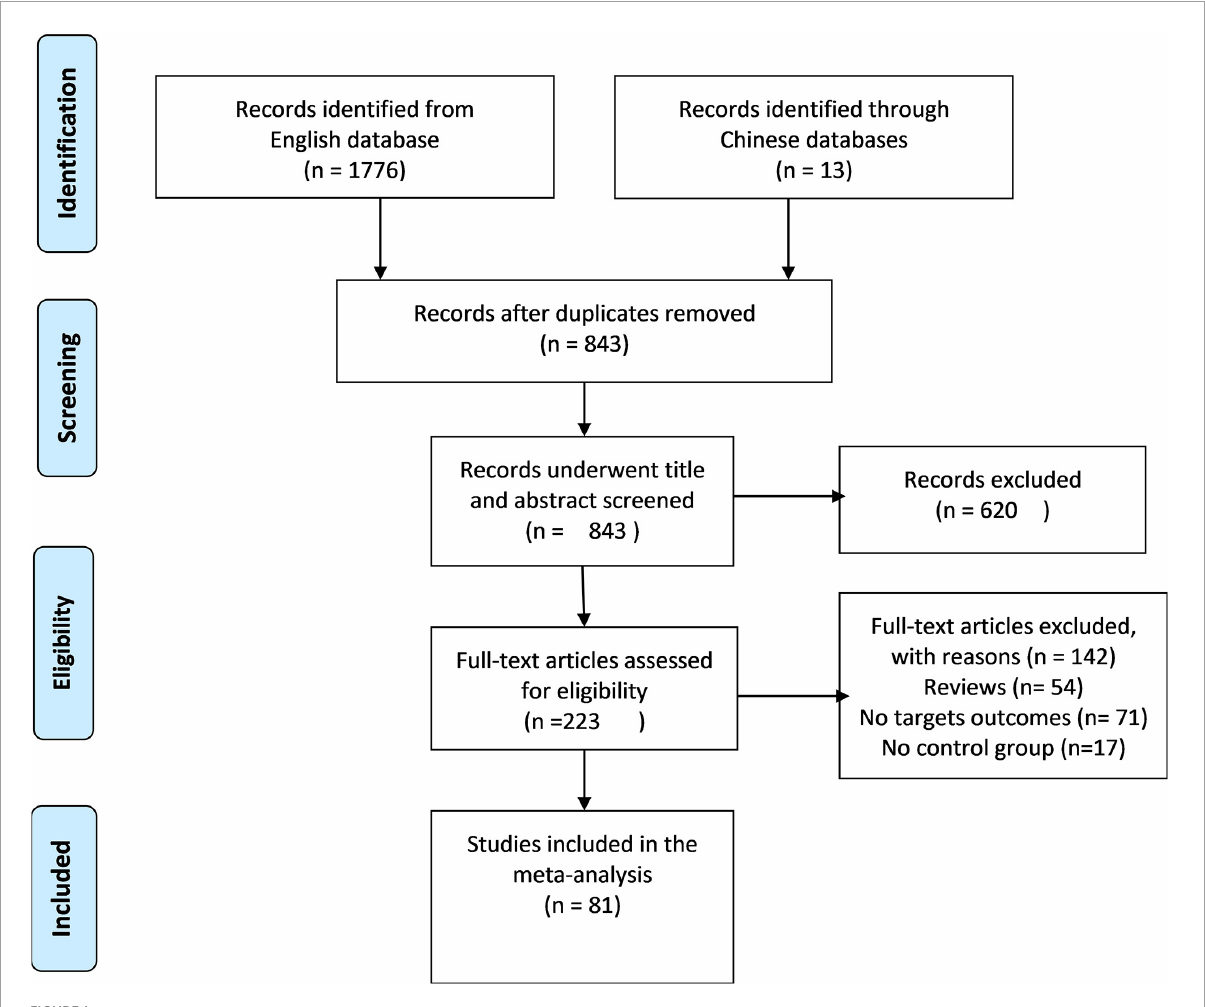
FIGURE1 Flow diagram of the study selection